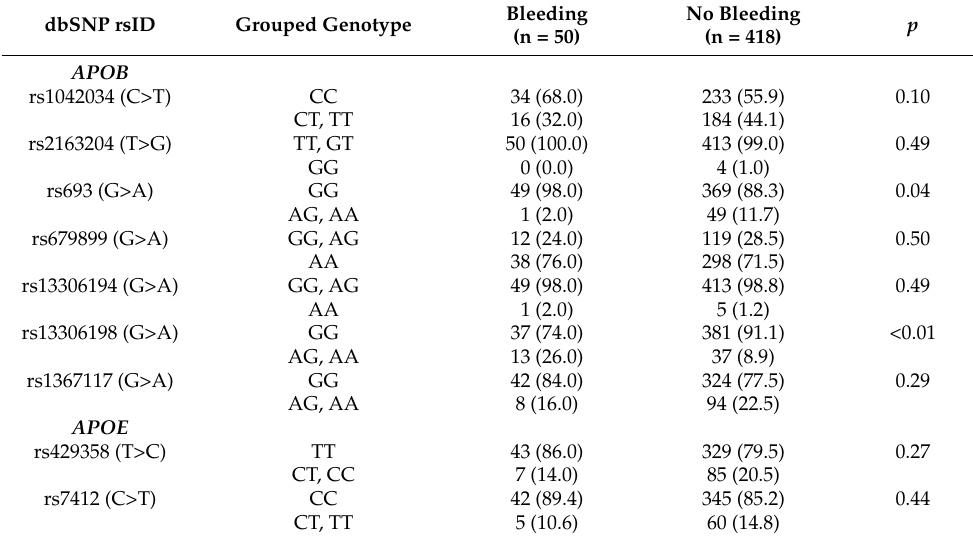
Table 3. Effects of APOB and APOE grouped genotypes on bleeding complication.